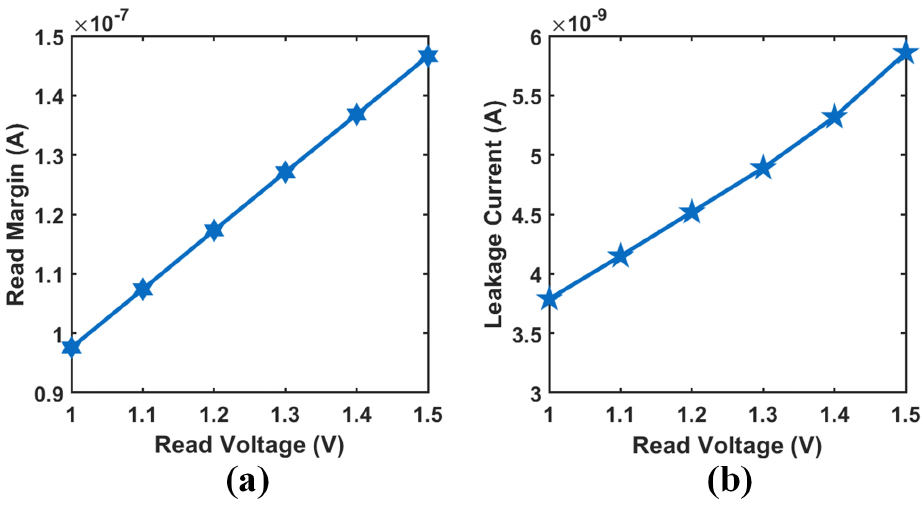
Figure 9. ( a ) RM under different read voltages and ( b ) LC under different read